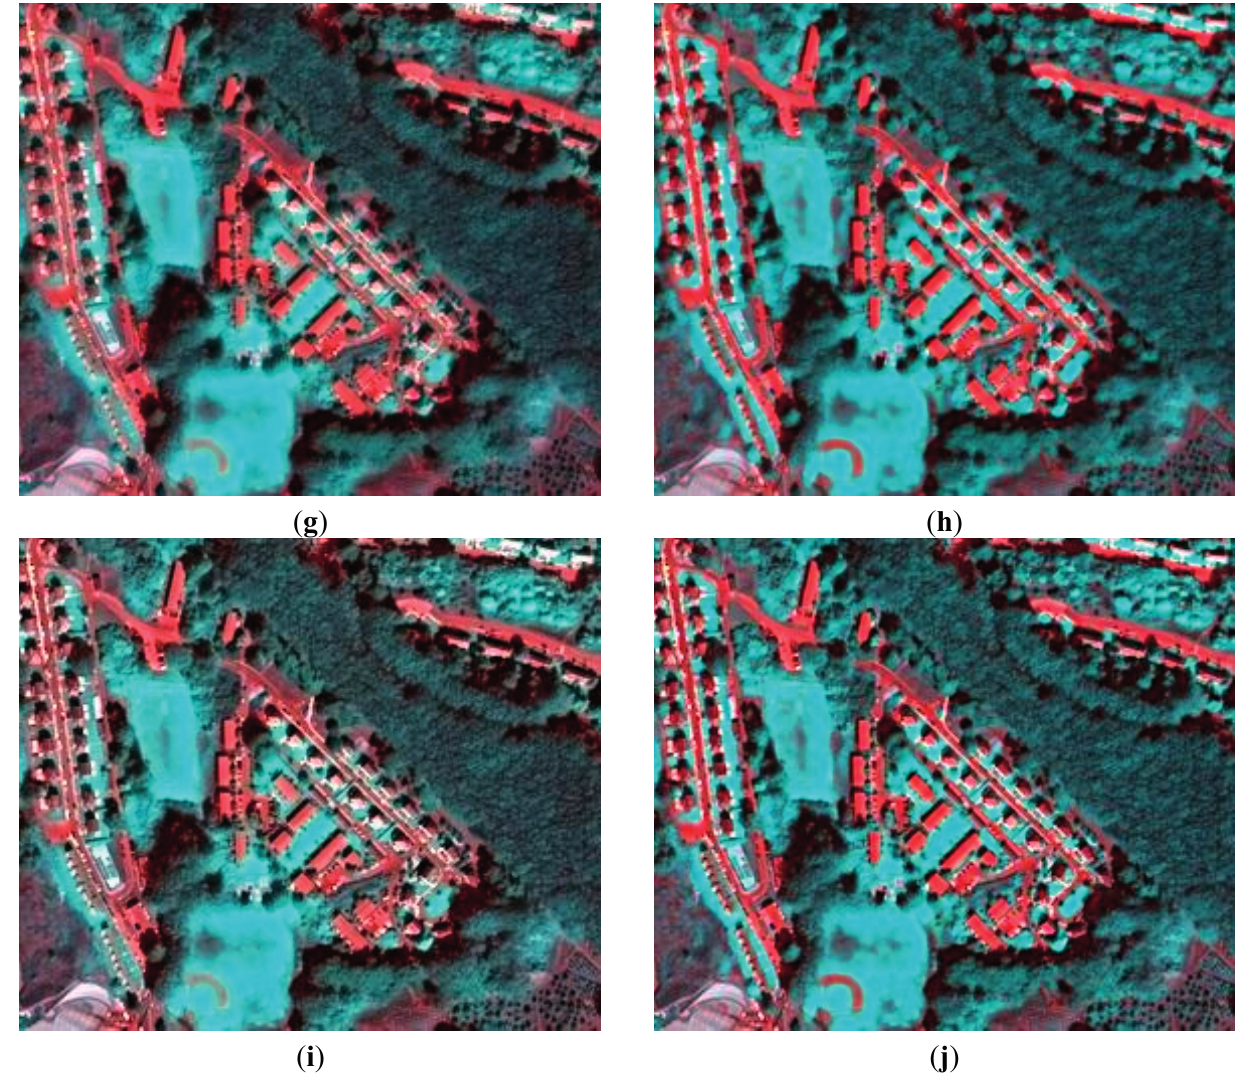
Figure 5. A subset, marked in the right white box in Figure 1, of different fusion results at the reduced scale of the WorldView-2 group 2 dataset. Bands 1, 7 and 8 are combined for RGB display. ( a ): Observed at a 2.0-m spatial resolution; ( b ): EXP; ( c ):